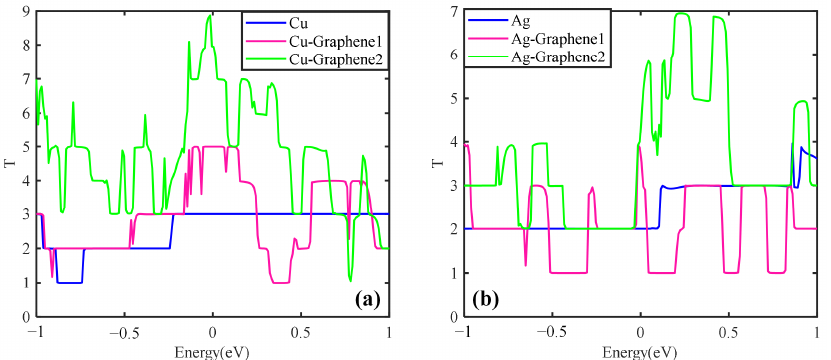
Figure 11. Transport curves of different metal and graphene composite electrode plates: ( a ) traditional copper electrode plate, single-layer graphene copper-clad electrode plate and double-layer graphene copper-clad electrode plate; ( b ) traditional silver electrode plate, single-layer graphene silver-clad electrode plate and double-layer graphene silver-clad electrode plate.